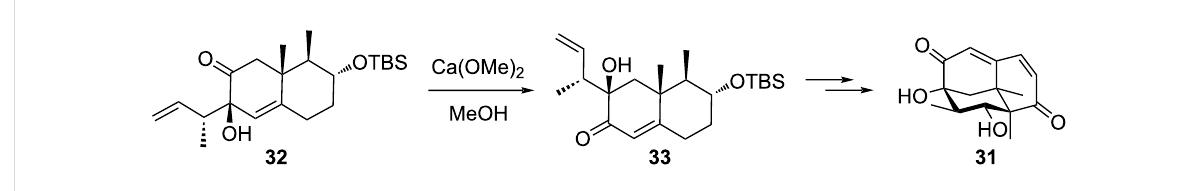
Figure 8: The diastereospecific α -ketol rearrangement of 32 to 33 , part of the total synthesis of periconianone A ( 31 ).